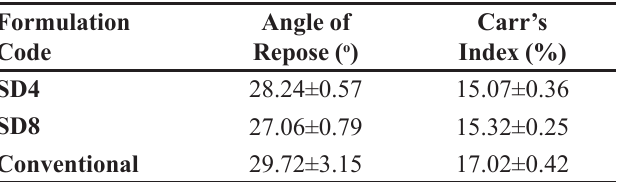
TABLE V- Flow properties of FPN and formulations (Mean ±